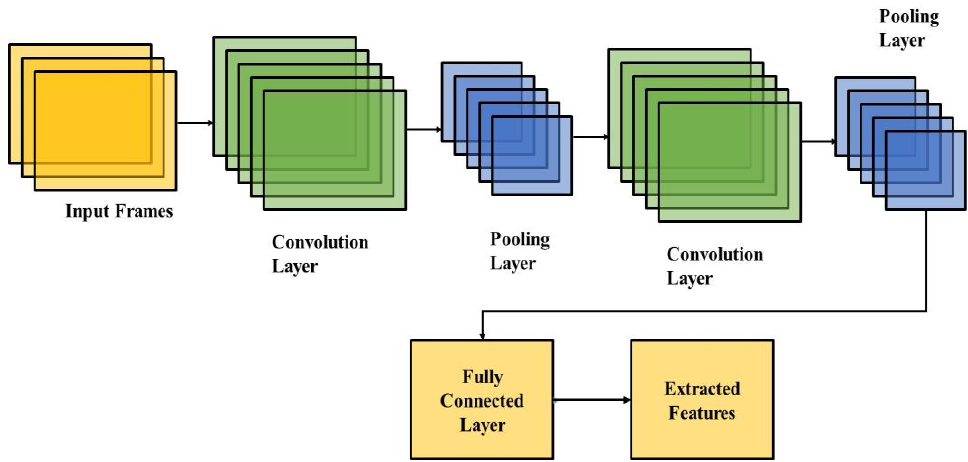
Figure 6. Convolutional Neural Network architecture for feature extraction process.